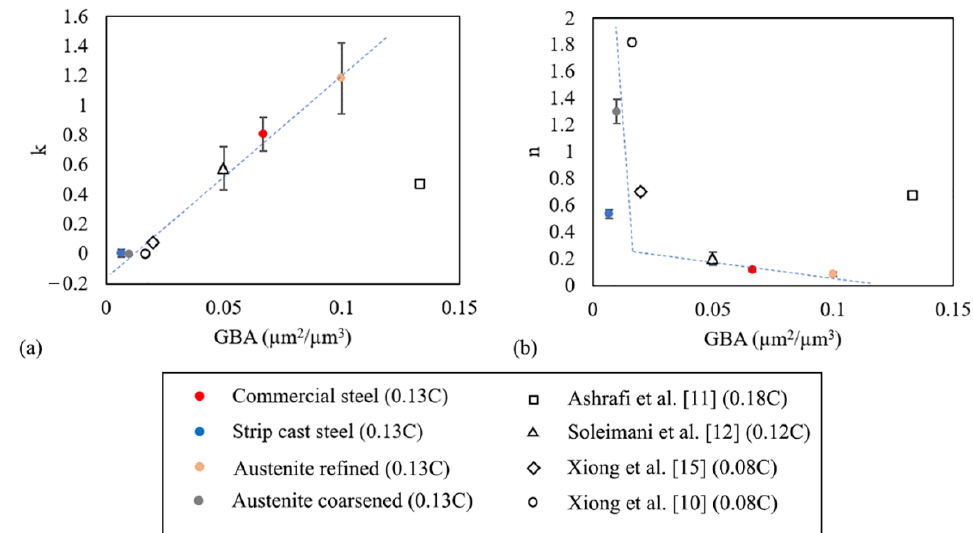
Figure 10. JMAK parameters for the current results, along with data obtained from the literature. ( a ) linear relationship between k and the GBA; ( b ) one outlier from Reference [11]. Note that some datasets from the literature have been extrapolated to an equivalent heat treatment temperature of 630 °C. Carbon content from literature data shown in brackets.